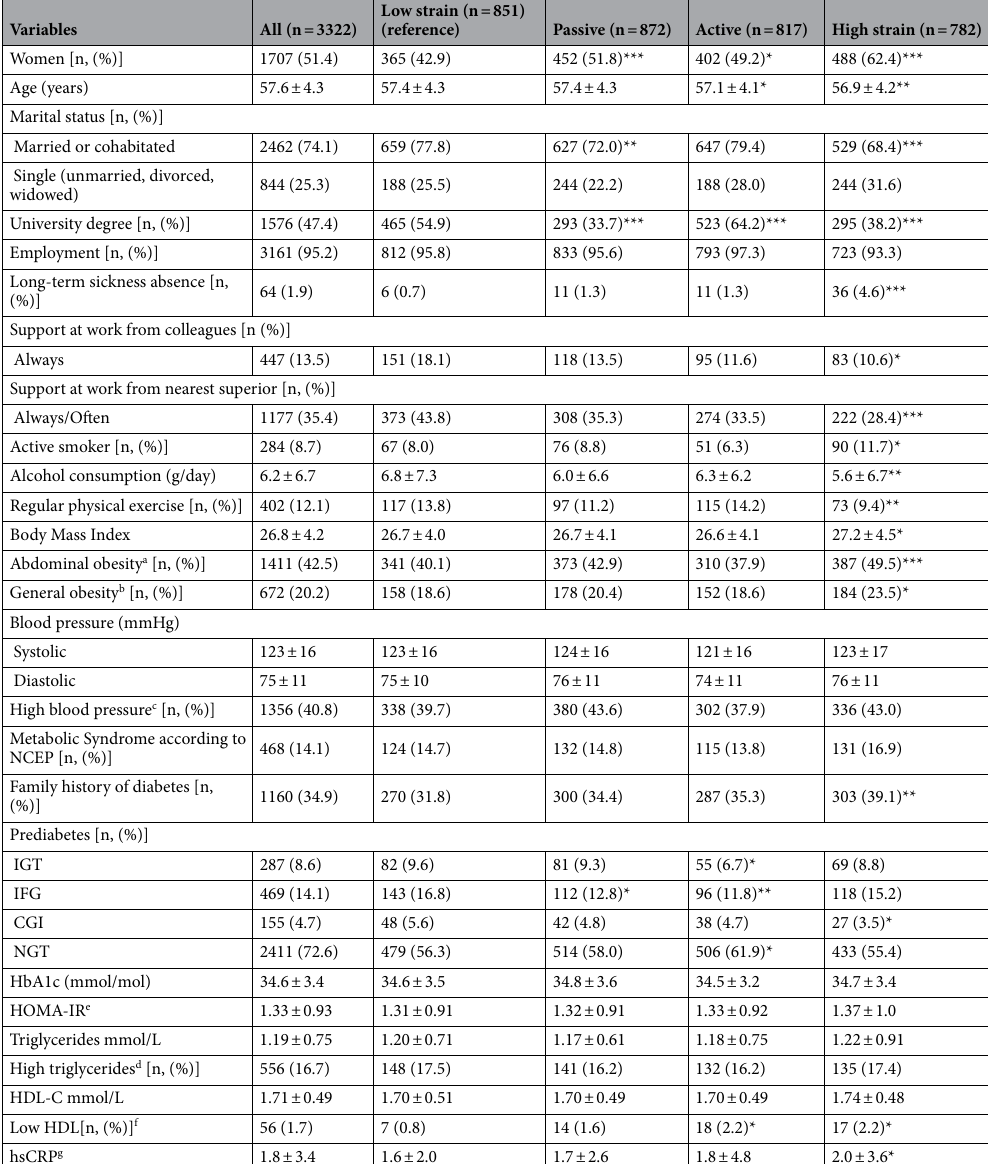
Table 1. Characteristics of the study population and the different groups of psychosocial work conditions. IGT, impaired glucose tolerance; IFG, impaired fasting glucose tolerance; CGI, combined